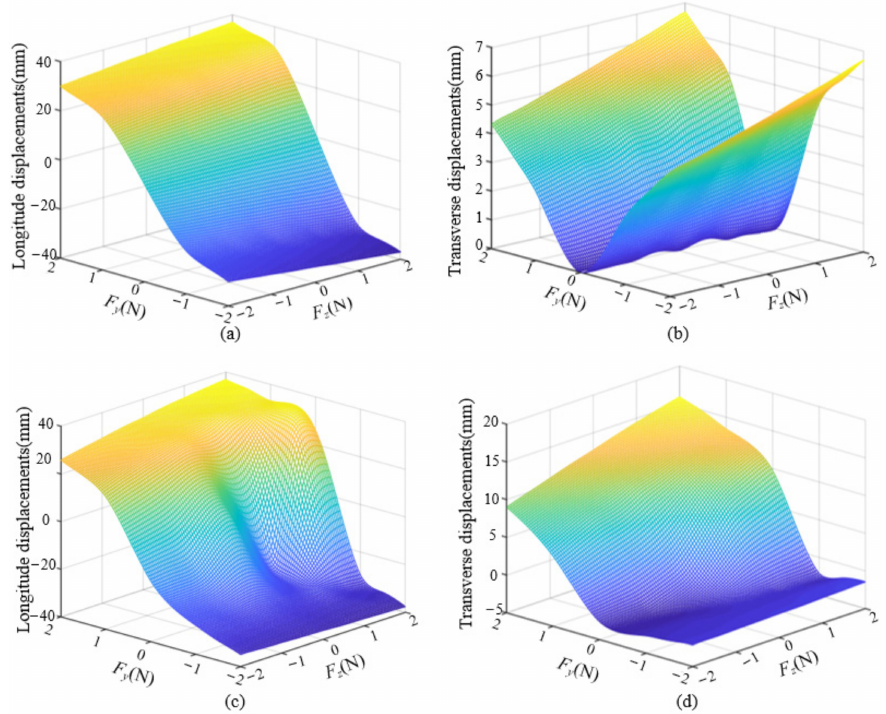
Figure 15. The longitudinal and transverse displacements of the end under external forces. ( a ) The relationship among the longitude displacements and two-directions in the initial config- uration. ( b ) The relationship among the transverse displacements and two-directions in the initial configuration. ( c ) The relationship among the longitude displacements and two-directions.in the bend- ing configuration. ( d ) The relationship among the transverse displacements and two-directions.in the bending configuration.